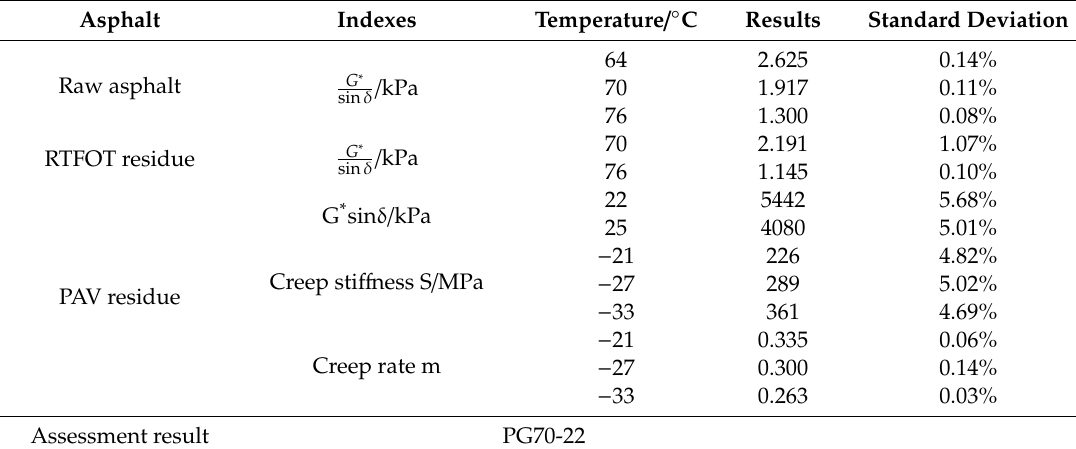
Table 8. PG grade results of SFSCMA (silica fume / SBS compound modified